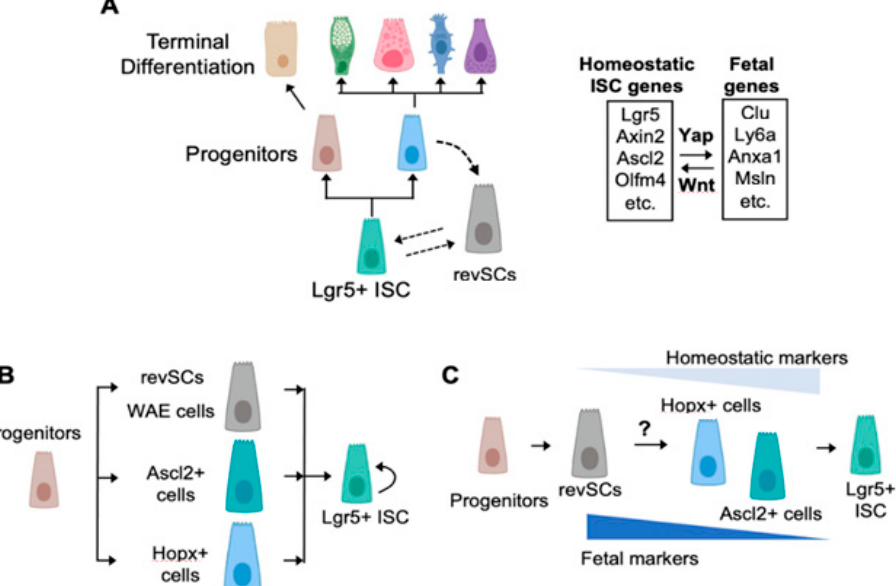
Figure 1. Stem-cell dynamics during intestinal homeostasis and regeneration. ( A ) Under homeostatic conditions, Wnt-driven Lgr5 + ISCs maintain epithelial turnover. Following injury, Lgr5 + ISCs are lost or reprogrammed, while lineage-committed progenitors adopt a Yap-dependent fetal signature and give rise to de novo Lgr5 + ISCs. ( B ) Multiple roads repopulate Lgr5 + ISCs. Various regenerative stem-cell populations have been described to date and may represent distinct dedifferentiation processes involved in gut regeneration. RevSCs [55] and wound-associated epithelial cells (WAE cells) [59] express several markers of the pseudostratified fetal gut epithelium and, thus, may represent equivalent cell types. Hopx + cells have been shown to co-express the fetal marker Trop2 (Tacsdtd2), while Ascl2 + cells are devoid of fetal markers. ( C ) Single-road model of Lgr5 + ISC replenishment. As an alternative scenario, we postulate that, under the influence of Yap signaling, revSCs are the earliest dedifferentiating cell type that may ultimately give rise to Hopx + and/or Ascl2 + cells, which acquire progressively more homeostatic features. During this process, fetal and homeostatic stem-cell genes would mark early and late stages of regeneration, respectively. Figure was prepared using Biorender.com.